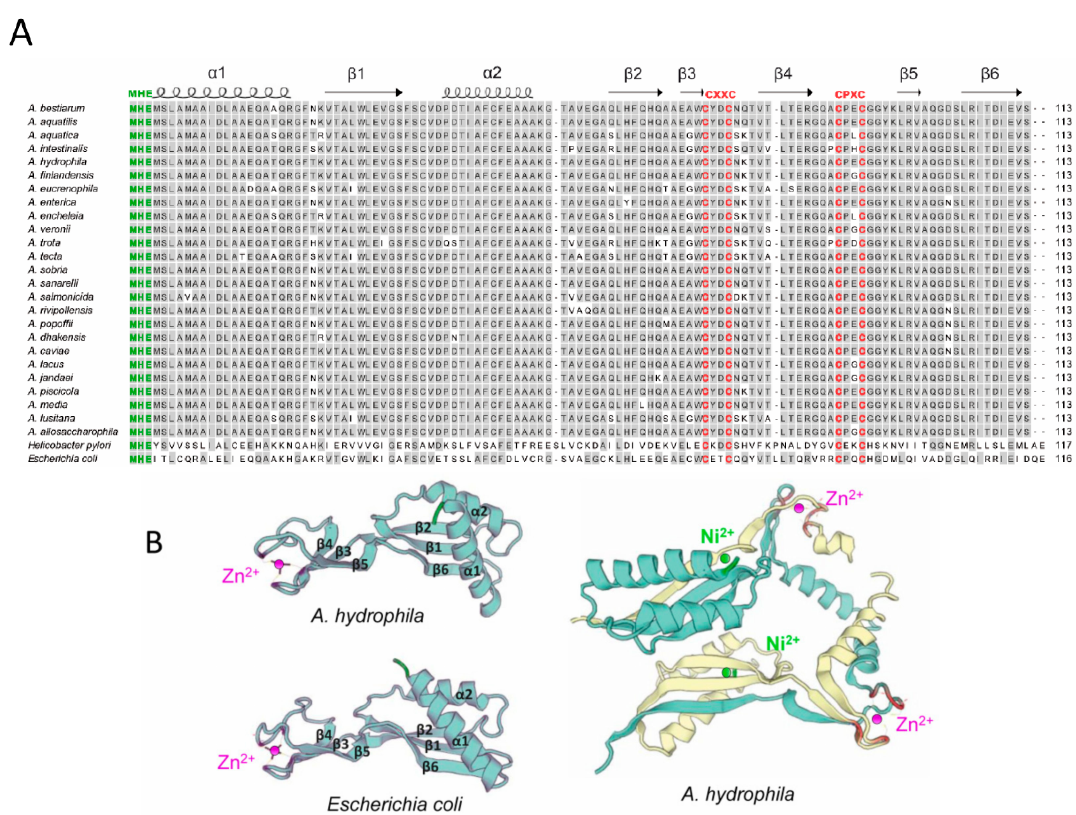
Figure 1. ( A ) Sequence alignment of the in silico-translated amino acid sequences of HypA proteins from 36 Aeromonas species, E. coli and H. pylori . The alignment was constructed with MegAlign. The MHE correspond to the motif of the Nickel binding domain (green) and CxxCnCPxP to the Zinc binding domain (red). The characteristic α -helices (wave lines) and a β -sheet (arrows) are represented. ( B ) Predicted monomeric and dimeric structure of HypA proteins from A. hydrophila type strain and E. coli constructed with Swiss Model online tool, the α -helices and the stranded β -sheet motifs are